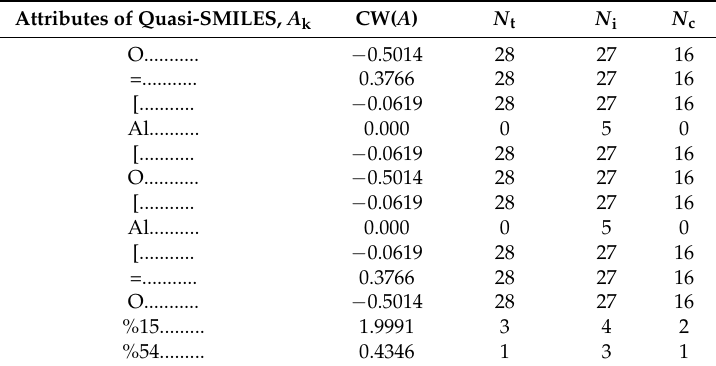
Table 4. Attribute calculation of DCW(1,30) for O=[Al]O[Al]=O%15%54.